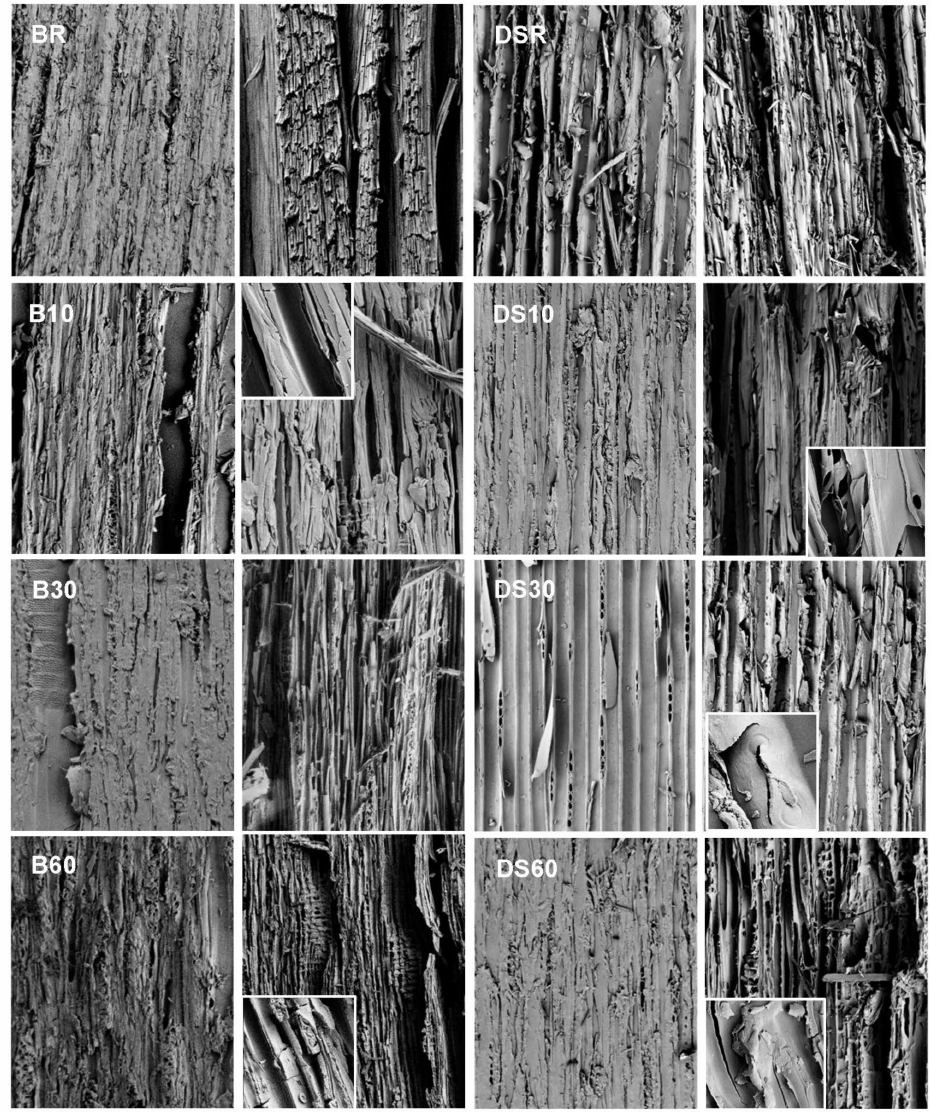
Figure 8. SEM images of birch (B) and dense spruce (DS) surfaces at a magnification of 100 × . Left: inside stored references; right: artificially weathered specimens. Selected details in insets (at 1000–2900 × magnification).